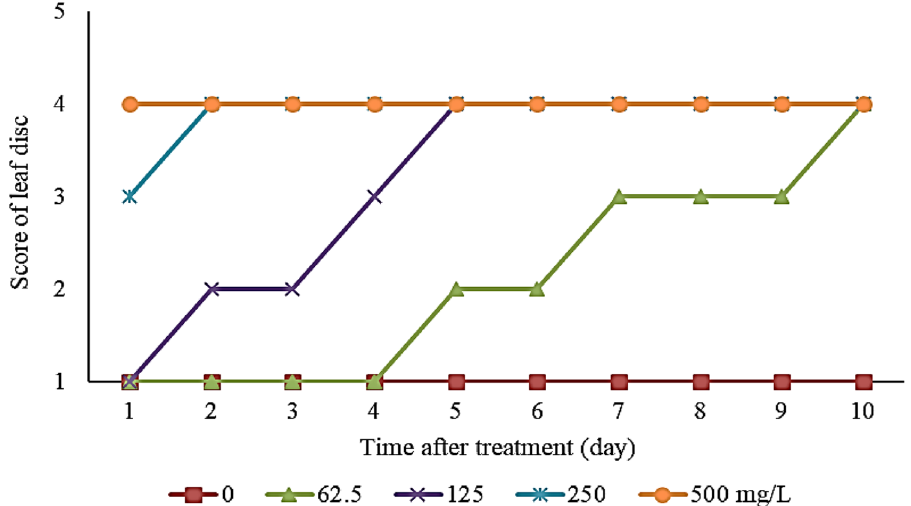
Figure 2. Phytotoxic effects of 5-(3-Fluoro-phenyl)-7-methyl-5H-thiazolo[3,2-a]pyrimidine-6-carboxylic acid ethyl ester ( c ) at 0, 62.5,125, 250 and 500 mg/L on green pigment degradation of Oldenlandia verticillata throughout 10 days of incubation period. Each score representing different colour retention of leaf disc. Score 1: Green—The leaf disc surface is completely green; Score 2: Green brownish—10–30% of leaf disc surface is dark brown in colour; Score 3: Brown greenish—50–80% of leaf disc surface is dark brown in colour; Score 4: Dark brown—More than 90% of the leaf disc surface, in aggregate, is dark brown.